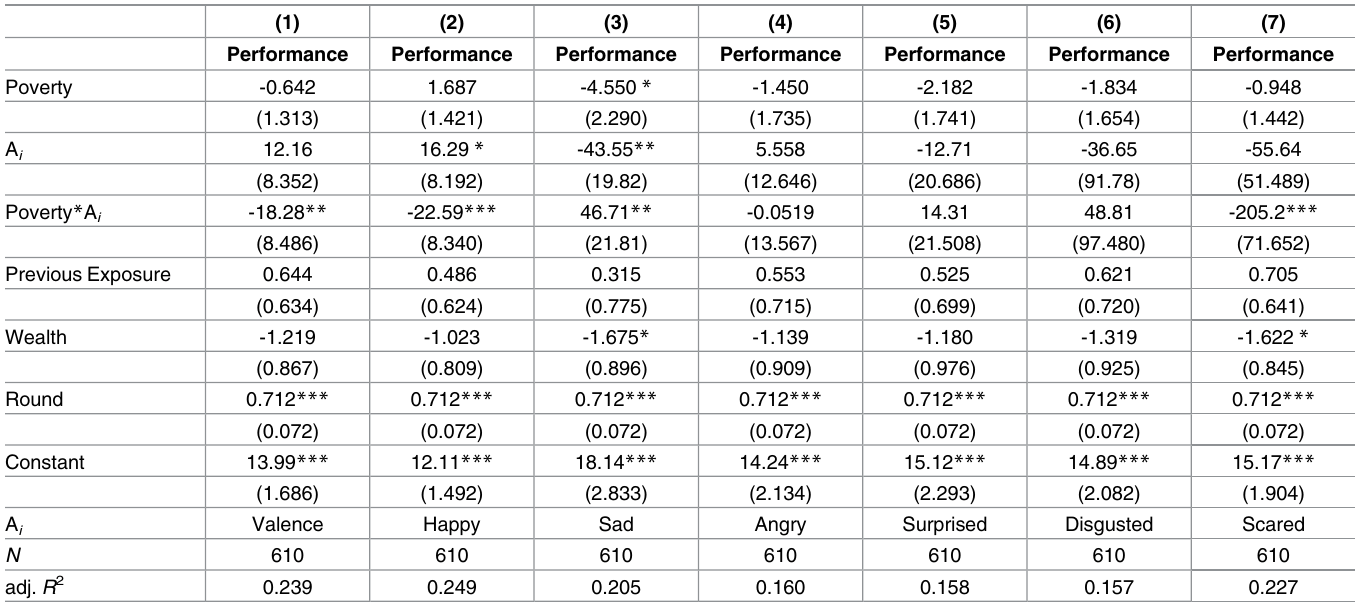
Table 6. Moderation Analysis, Physiological MeasuresTaken Before Video is